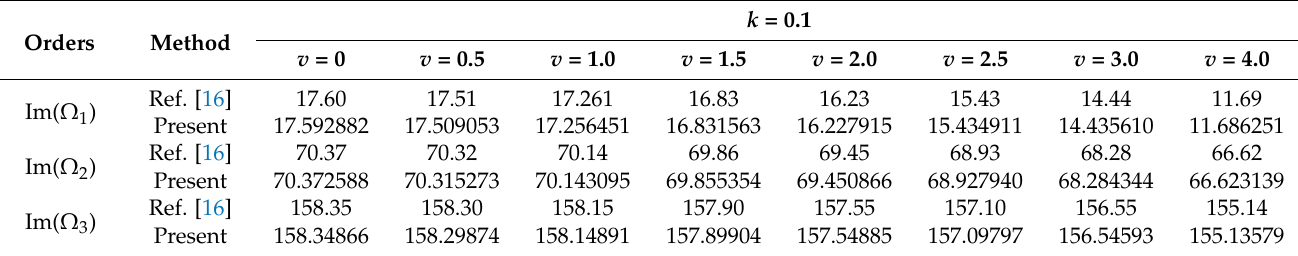
Table 2. The calculated values of the first three dimensionless natural complex frequencies of the FGM simply supported beam under different axial motion velocities v ( k = 0.1).